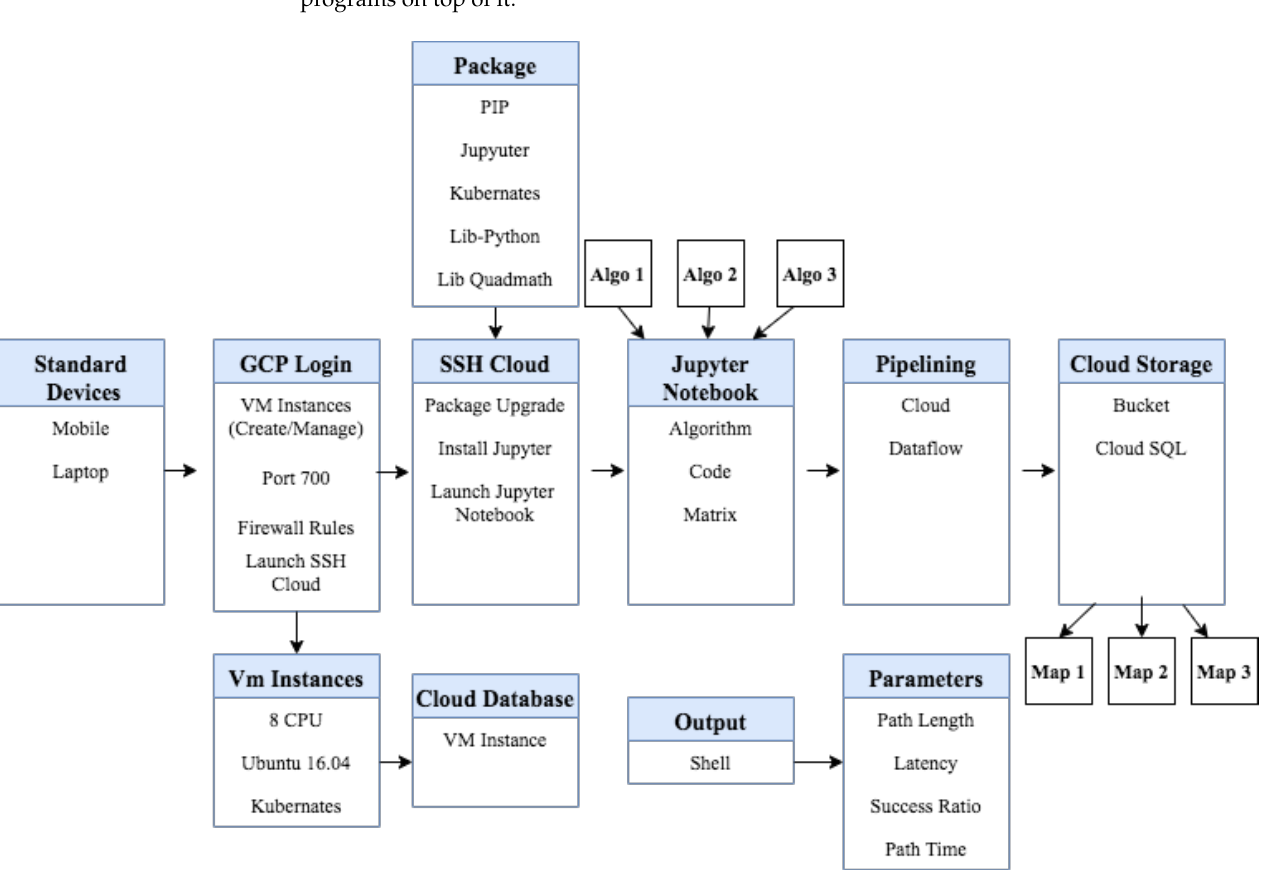
Figure 4. Proposed architecture for robot path planning using Google Cloud Computing